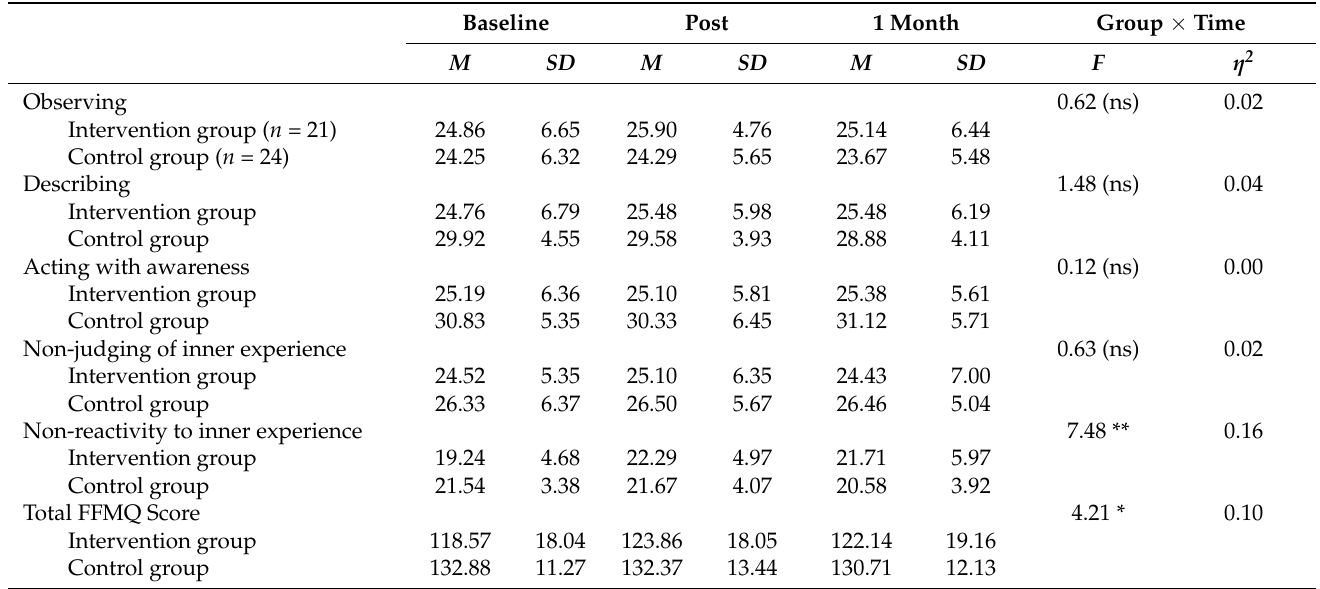
Table 4. Descriptive and inferential statistics for all aspects of mindfulness ( n =